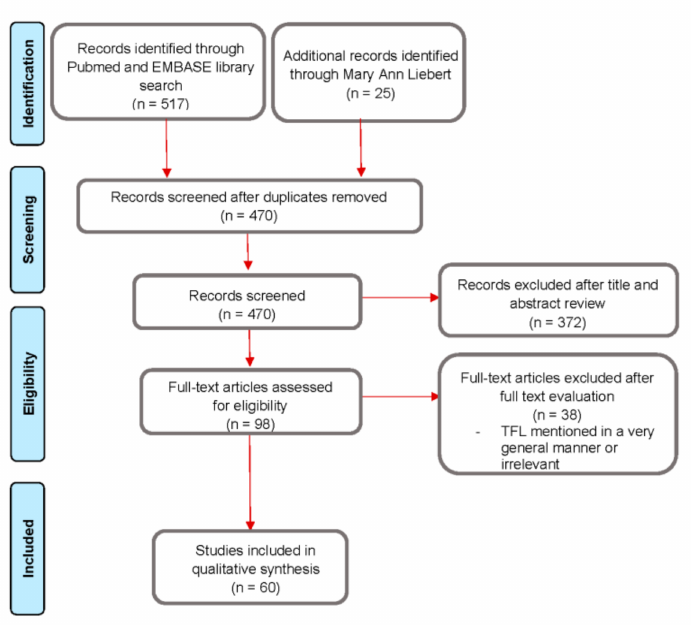
Figure 1. Flow chart of the literature